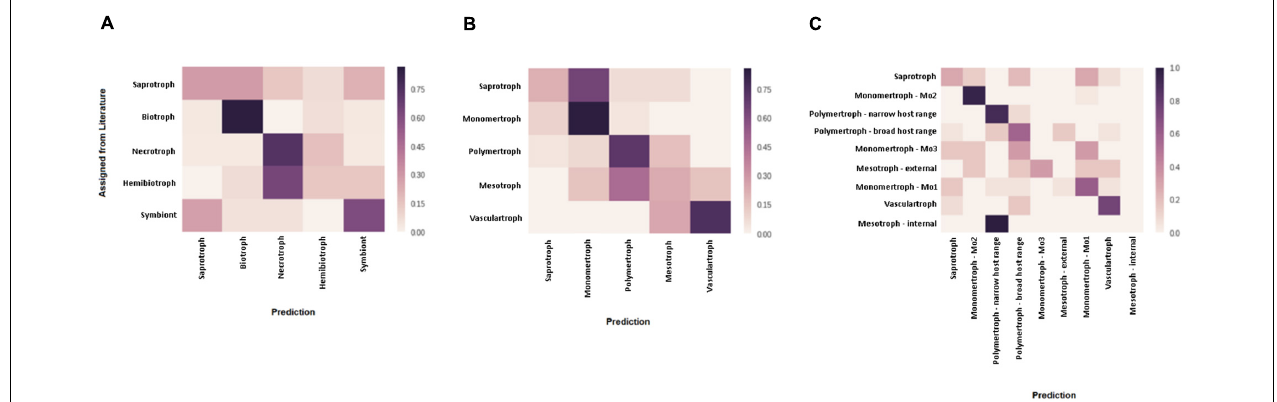
FIGURE 3 | Assessment of predicted CATAStrophy classifications of fungal trophic phenotypes. Confusion matrices were used to assess the relative suitability of each nomenclature [literature-derived terms (A) compared, novel major classes (B) , and novel sub-classes (C) ] for use in the CATAStrophy RCD method. CATAStrophy predictions were assessed for accuracy compared to the assigned terms listed in Supplementary Data Sheet S1